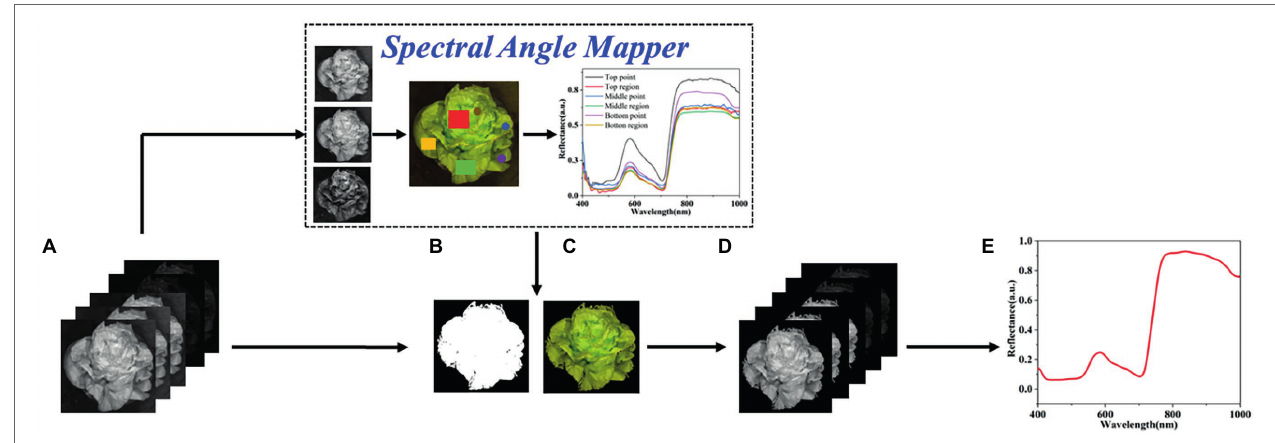
FIGURE 2 | The process of plant spectra extraction. (A) Calibrated hyperspectral images, (B) binary plant mask, (C) masked RGB plant, (D) 256 bands corresponding to the ROI, and (E) extracted plant mean reflectance